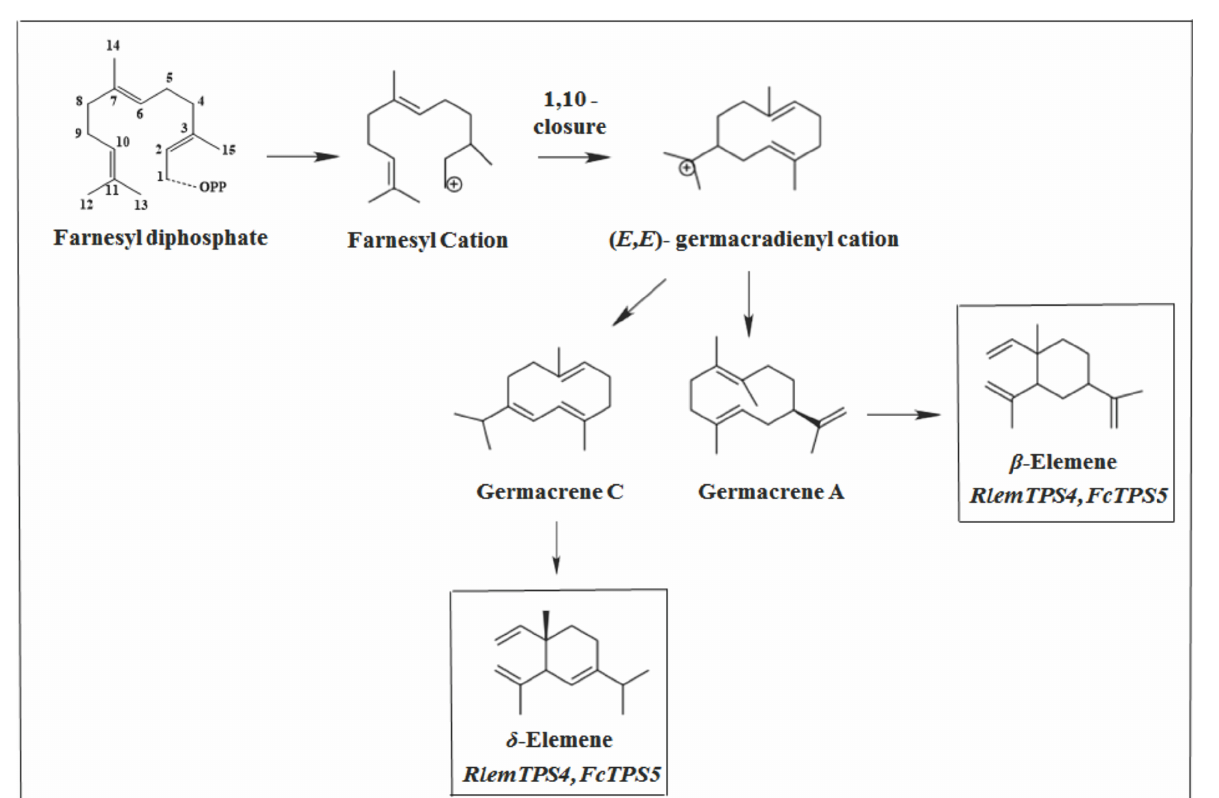
Figure 8. Types of primary cyclization of compound β -elemene and δ - elemene.